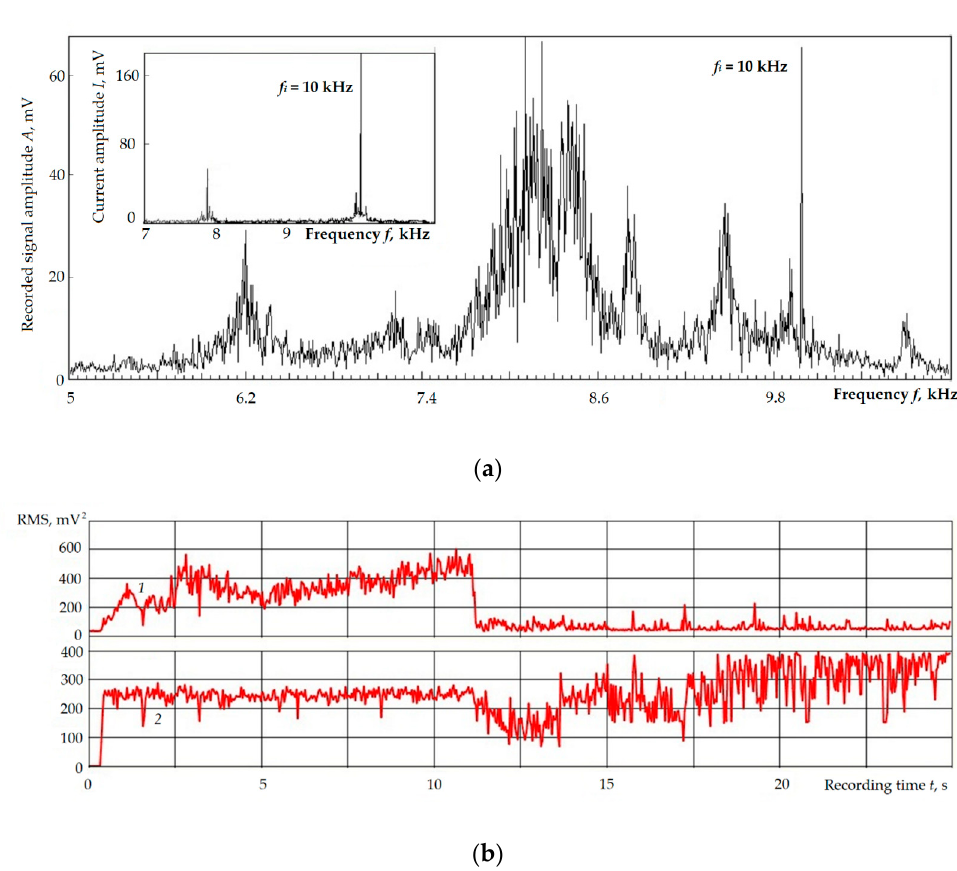
Figure 4. Spectrum of the recorded amplitude A and electrical current I signals and its root-mean-square value in recorded time: ( a ) spectra; ( b ) recorded root-mean-square value of the signal amplitude ( 1 ) and electrical current ( 2 ).